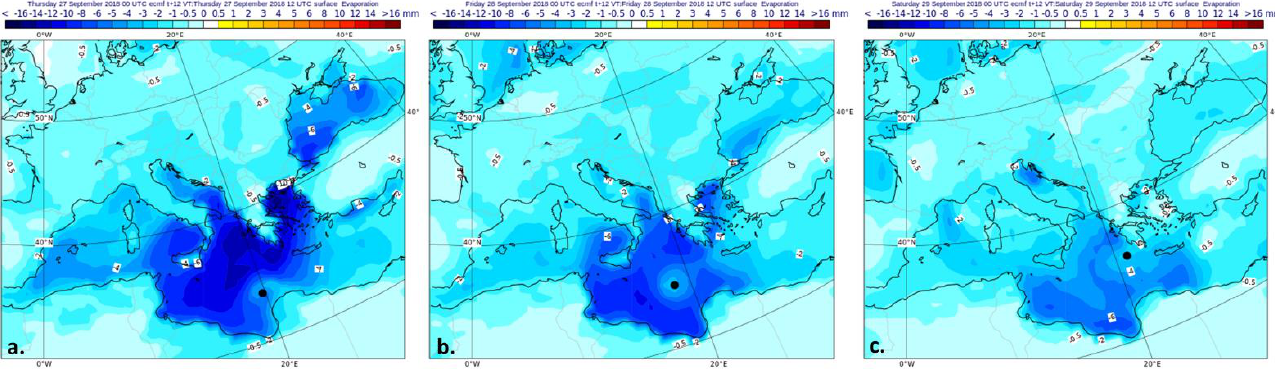
Figure 12. Twelve hour accumulated evaporation (in mm of water equivalent) ( a ) 27/00 – 27/12 UTC, ( b ) 28/00 – 28/12 UTC, and ( c ) 29/00 – 29/12 UTC. The evaporation is represented by negative values, denoting transfer of energy from the surface to the atmosphere. Black dot on the maps indicates the location of the system centre.